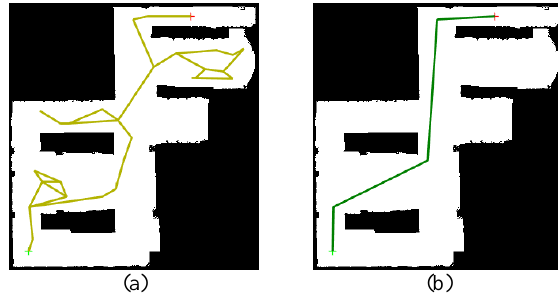
Figure 4 . Path before (a) and after (b)